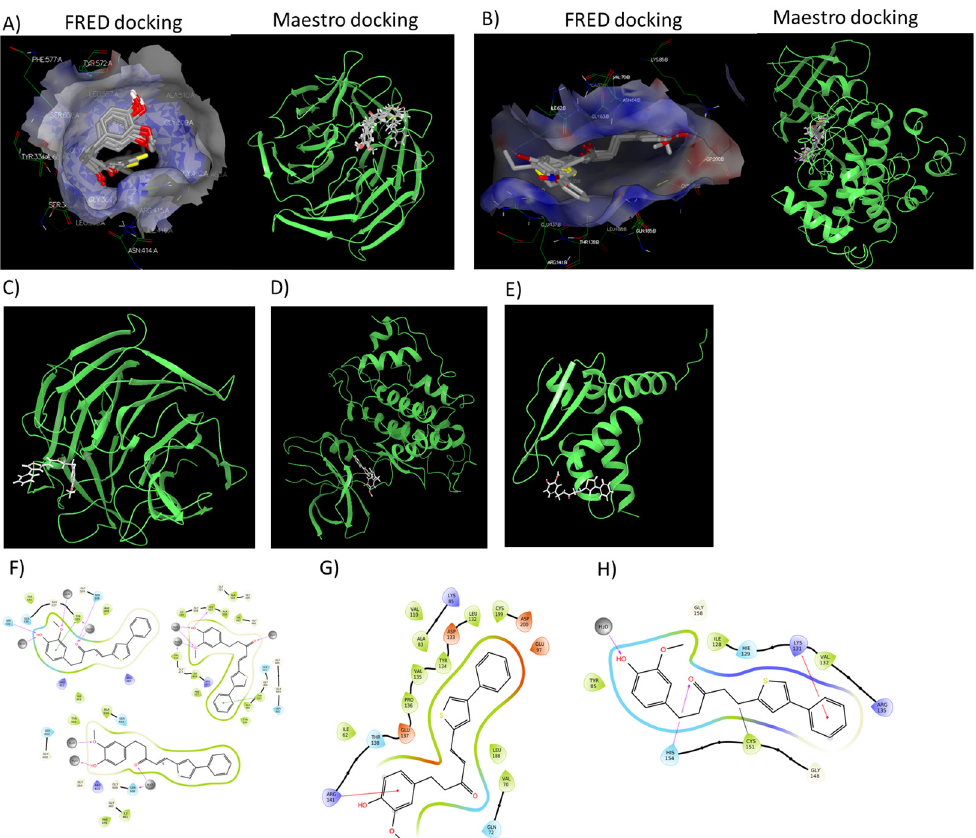
Figure 7. In silico studies of 6-shogaol and STCs with the protein of interest. The in silico studies were performed using FRED and Schrodinger Small Molecule Discovery Suite. The poses of all compounds docked in the ( A ) Kelch protein of KEAP1 (PDB ID: 4IQK) and ( B ) GSK-3 β (PDB ID: 1Q41) were visualised using 3-dimensional interaction diagrams. Molecular dynamics studies were carried out on the most potent compound, STC5, with ( C ) Kelch protein of KEAP1 (PDB ID: 4IQK), ( D ) GSK-3 β (PDB ID: 1Q41), and ( E ) KEAP1 BTB domain (PDB ID: 5DAF). The 2-dimensional interaction diagram between the STC 5 and the protein of interest, ( F ) 4IQK, ( G ) 1Q41, and ( H ) 5DAF, are shown. Table 3. The docking scores (FRED score and XP score) and binding free energies ( Δ G 0 ) of the test compounds in the binding pockets of 4IQK and 1Q41.